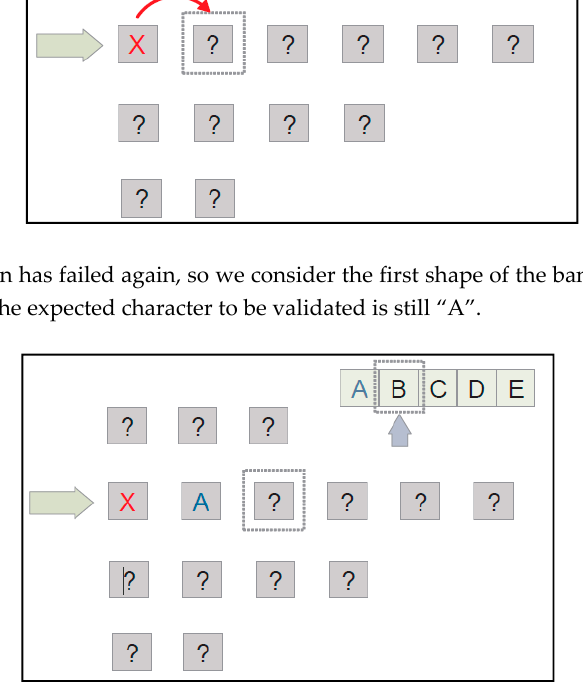
Figure 12. We finally managed to successfully validate the “A” character. The acquired shape has been successfully treated. The expected character “A” has been verified. We move onto the next expected character not verified and the next acquired shape not treated for